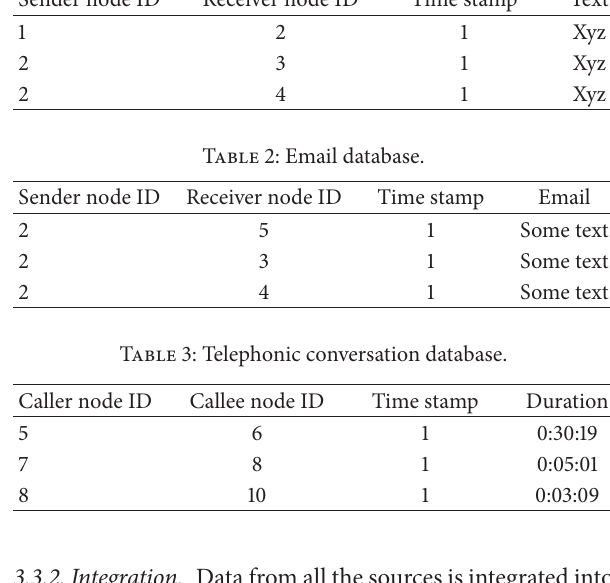
Table 5: Travel record